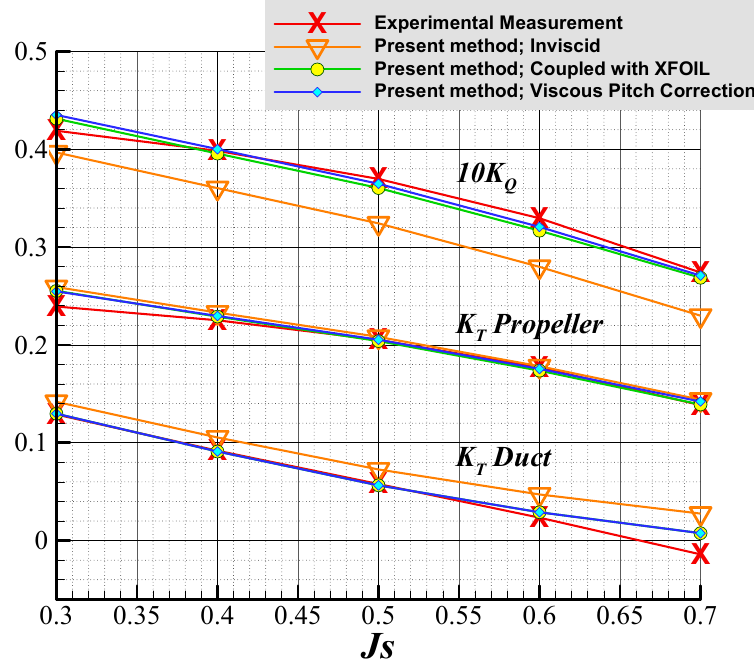
Figure 6. Correlations of the predicted force performance of the KA4-70 propeller with duct 19Am (with sharp trailing edge), as shown in Figure 7, from the presented method with/without viscous corrections, and experiment. Full Wake Alignment (FWA) is applied to the panel method.